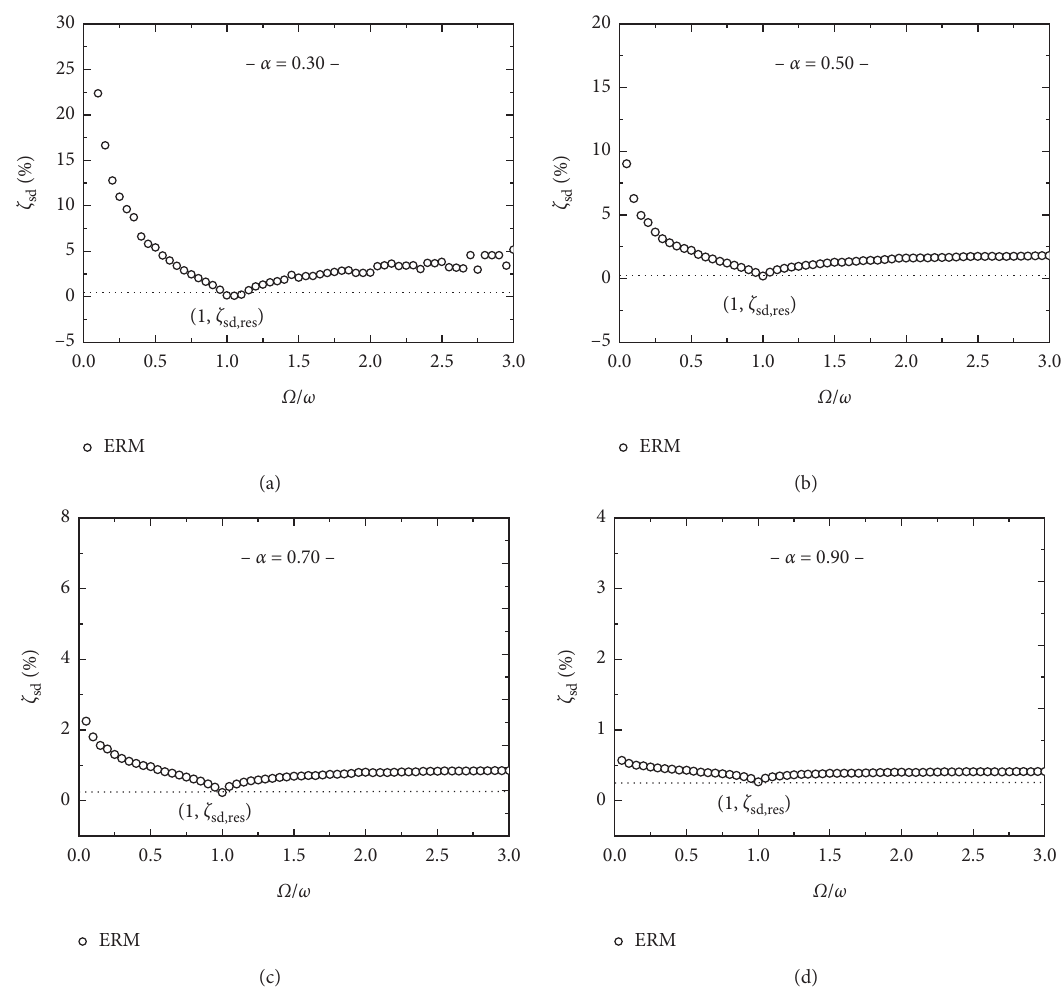
Figure 6: Relationship between ADR ζ � 0.30; (b) α � 0.50; (c) α � 0.70; (d) α � sd and the frequency ratio Ω / ω : (a) α